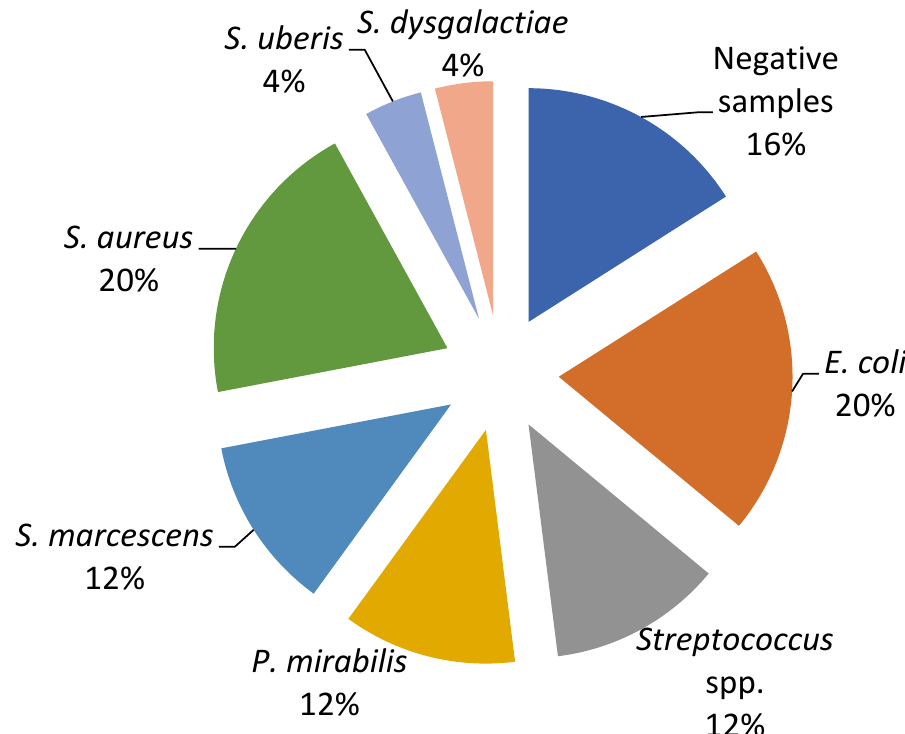
Figure 2. Percentage ratio of bacterial strains in the collected milk samples on Farm B.